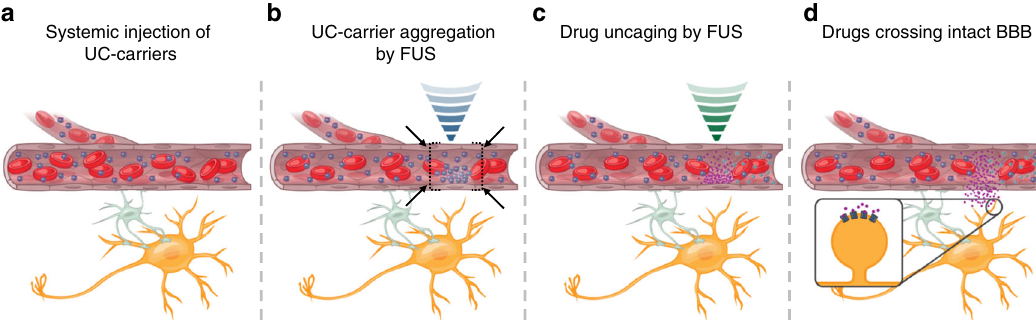
Fig. 1 Concept of focal aggregation and uncaging of ultrasound-controlled drug carriers. a UC-carriers are continuously infused (blue particles within the capillary) intravenously, which circulate stably. b UC-carriers are fi rst aggregated locally by acoustic radiation forces generated by ultrasound waves (blue). c The locally concentrated UC-carriers are then uncaged to release drugs using acoustic uncaging forces produced by ultrasound waves (green). d Small molecules diffuse across the intact BBB reaching their molecular targets (ultrasound beam is not to